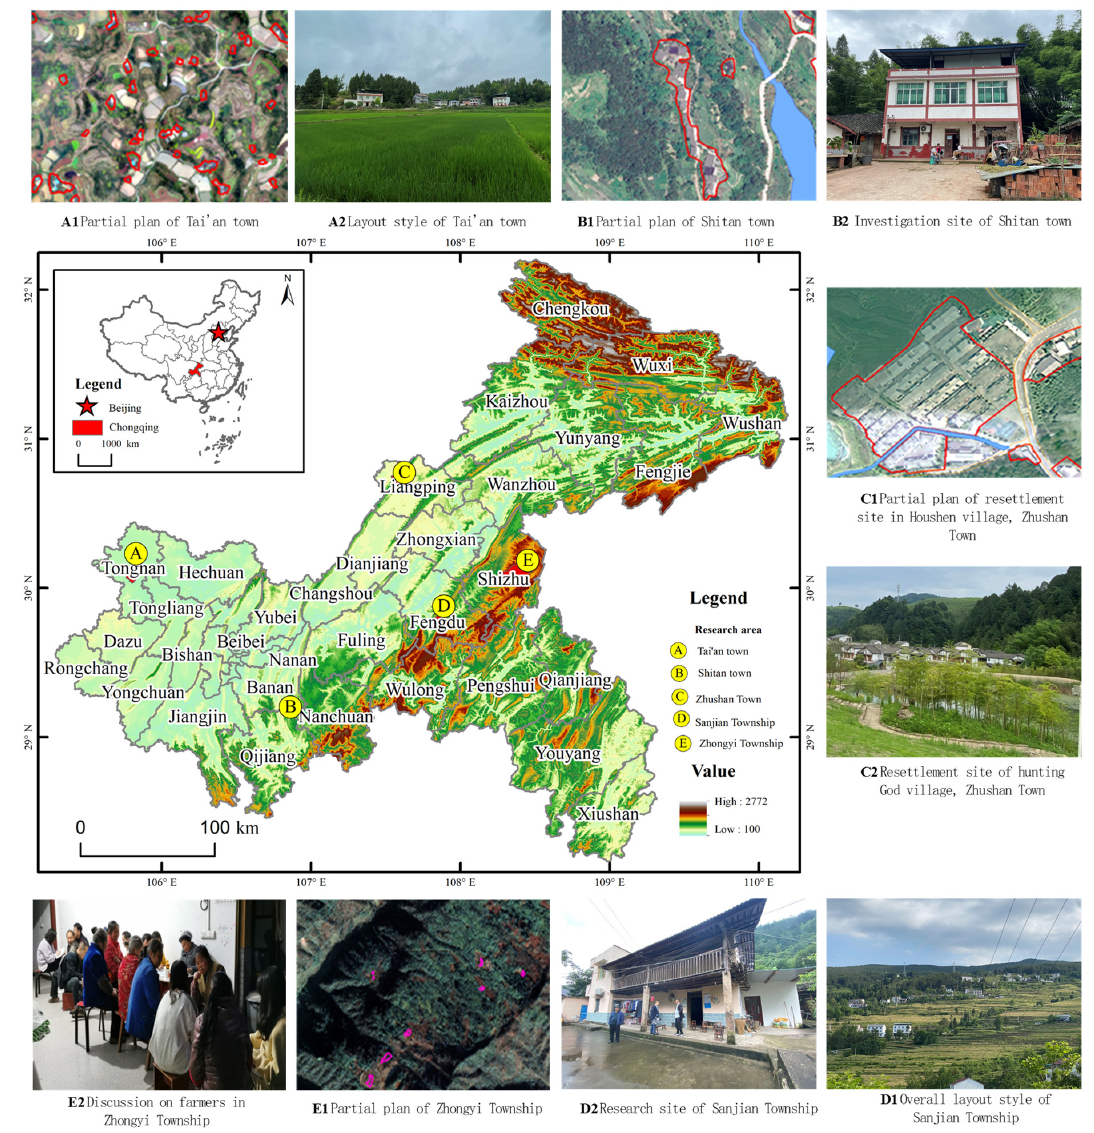
Figure 1. Survey area